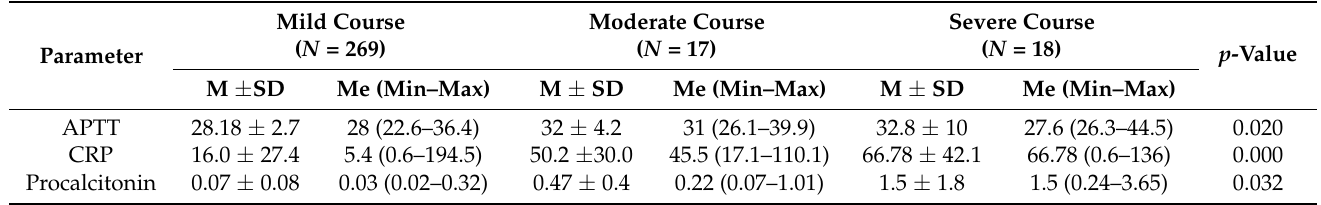
Table 3. Severity of COVID-19 in pregnant women ( N = 304) versus selected maternal blood parame- ters.